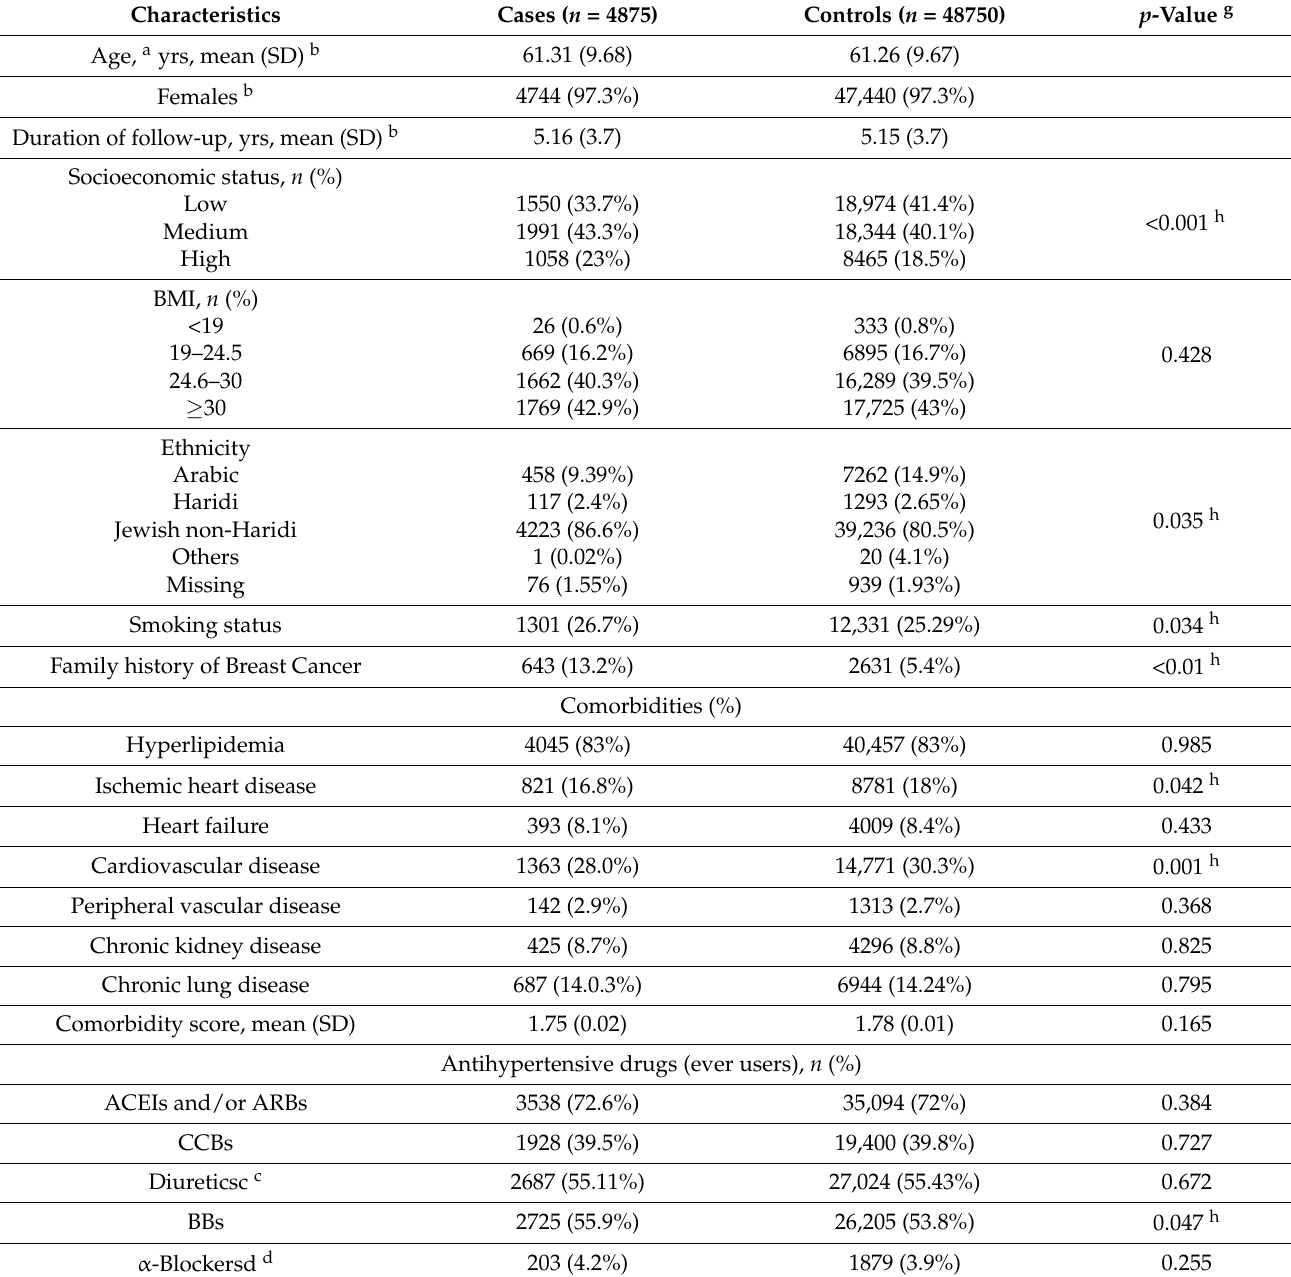
Table 1. Baseline characteristics of breast cancer cases and matched